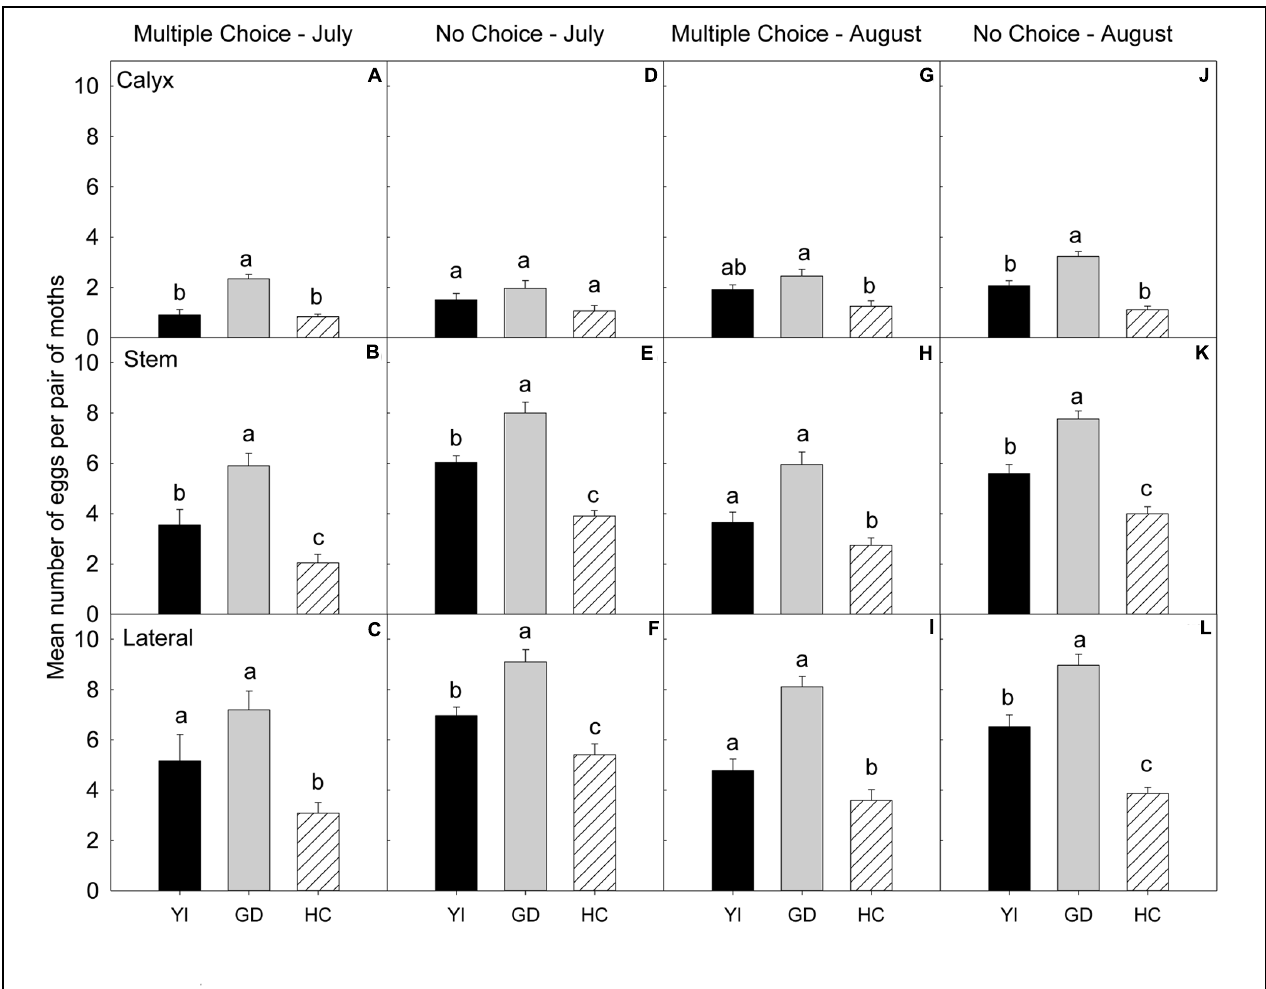
FIGURE 5 | Relative susceptibility of different apple cultivars for oviposition of codling moth during 2008. Mean number of eggs per pair of moths per fruit on calyx, stem, and lateral sides of fruits of different cultivars are shown in multiple-choice tests- July 2008 (A–C) and August 2008 (G–I) and no-choice tests- July 2008 (D–F) and August 2008 (J–L) . YI, York Imperial, GD, Golden Delicious, HC, Honeycrisp. N = 8 for all the multiple-choice tests, and N = 15 for all the no-choice tests. Each bar represents standard error of mean. Different letters over bars indicate significant difference ( P <